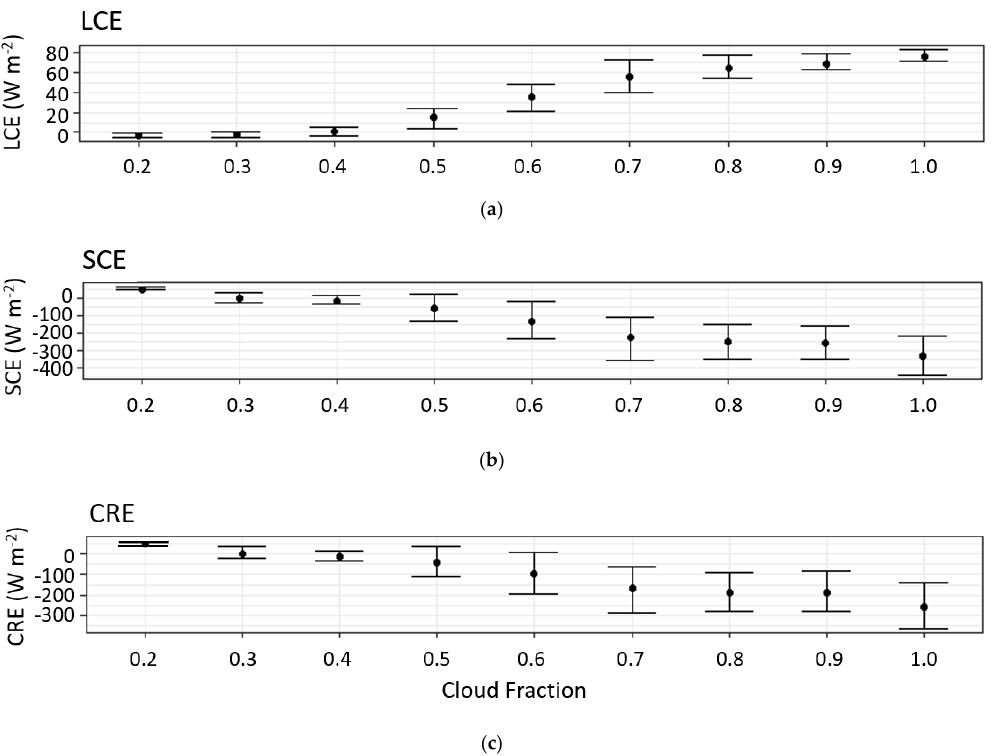
Figure 8. ( a ) Long-wave cloud radiative effect (LCE), ( b ) short-wave cloud radiative effect (SCE), and ( c ) net cloud radiative effect (CRE) versus cloud fraction obtained from all observations. Medians are shown as filled dots and the bars span the interquartile range. The data are averaged in intervals of 0.1 and are centred at the upper limit of each bin (for example, the bin at 0.1 is the average for 0.0 to 0.1).